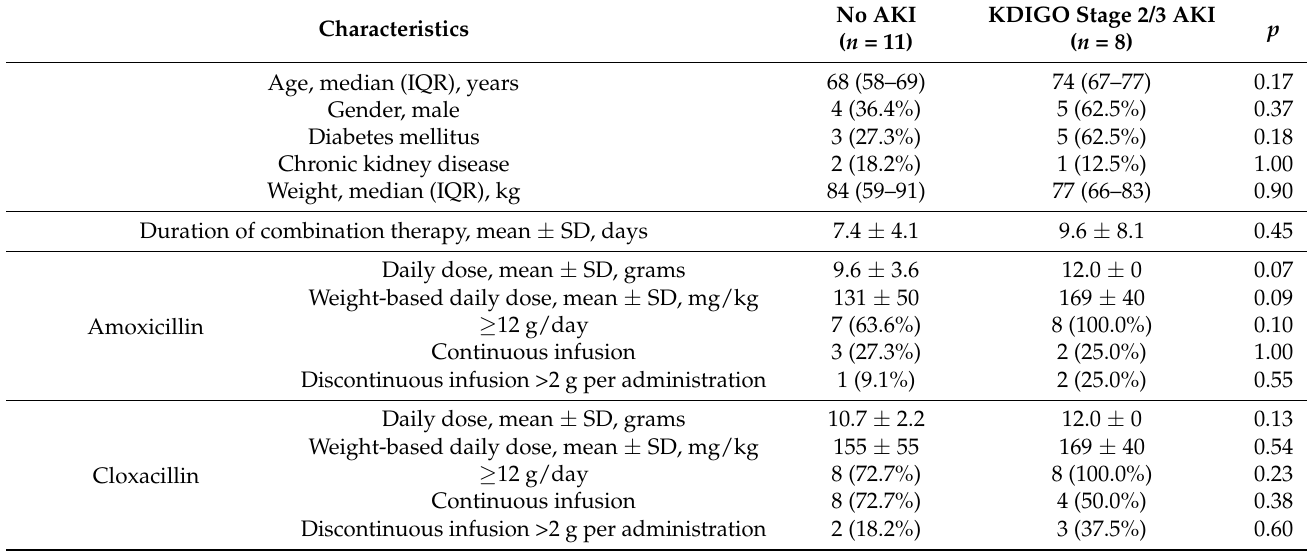
Table 3. Comparison between patients with KDIGO stage 2 or 3 AKI and patients without AKI.